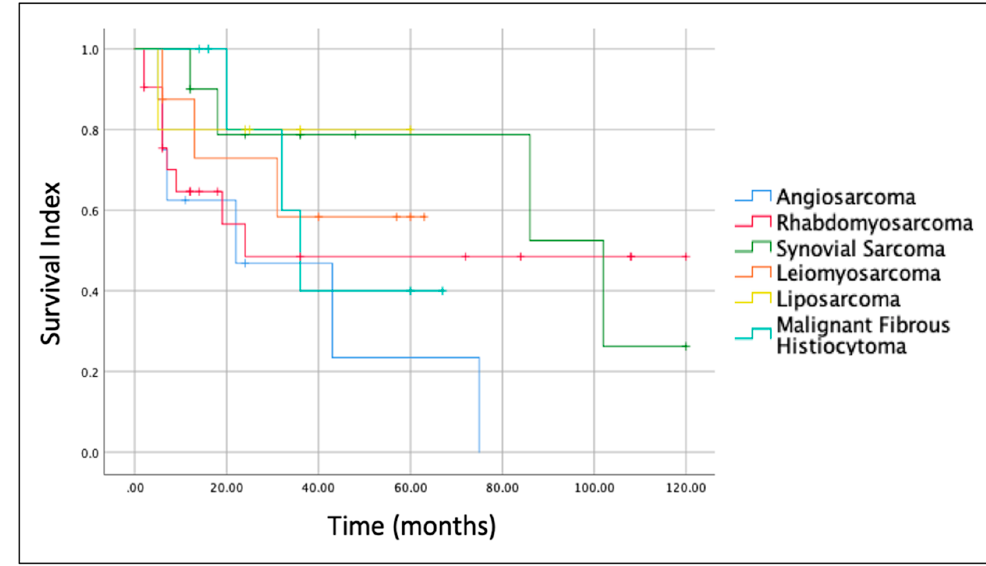
Figure 4. Kaplan-Meier curves and overall survival (OS) of the most frequent histological type of parotid gland sarcomas included in this study.